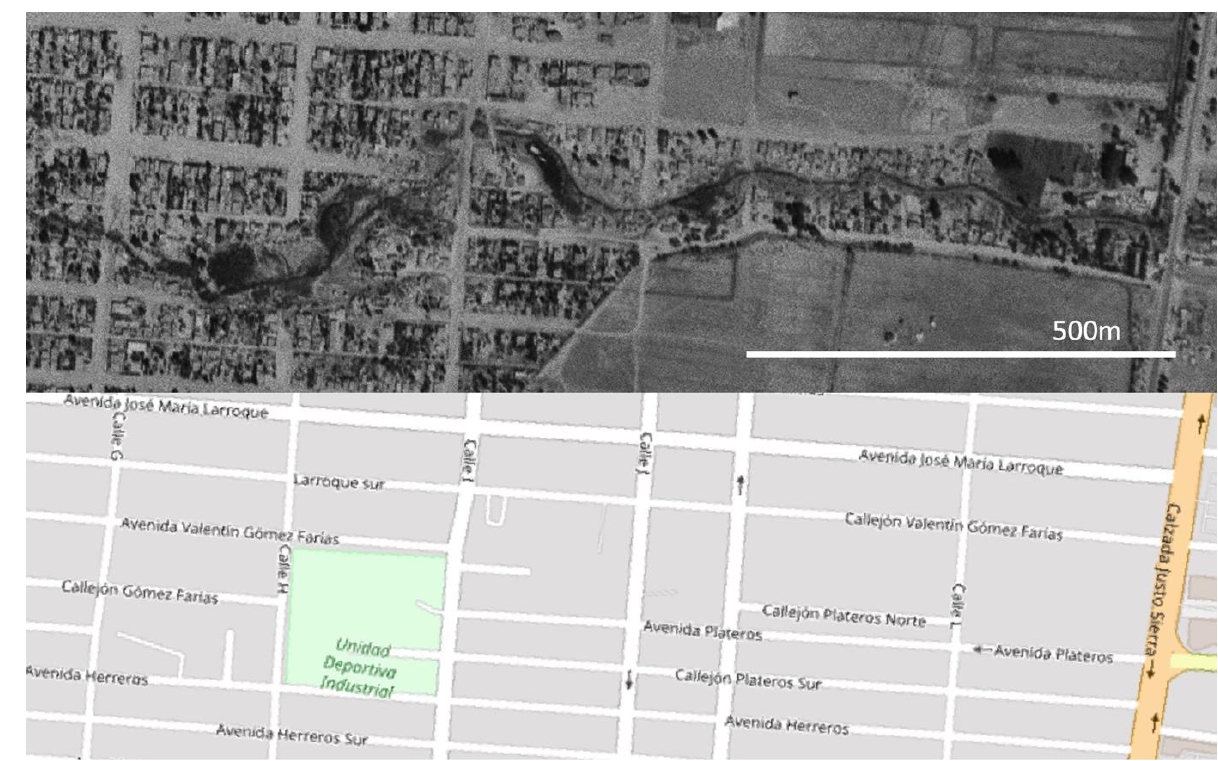
Figure 7. Mexicali 1953 on the aerial image ( above ) and 2021 on the OSM map ( below ) show an old river covered by a settlement area.